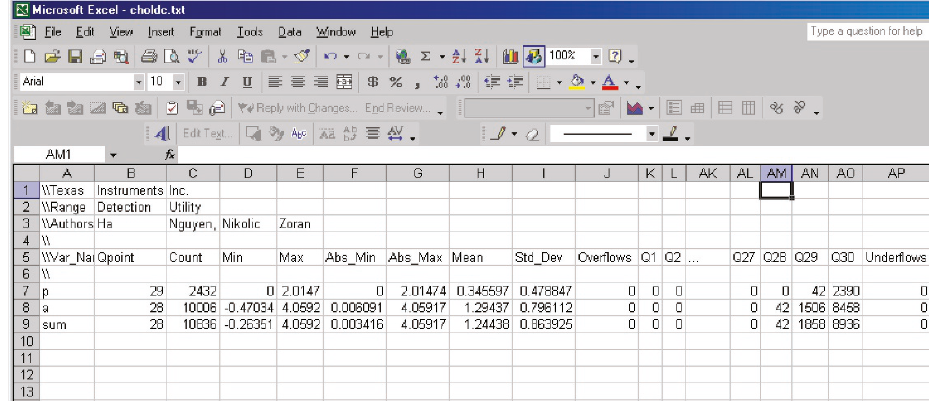
Figure 8: Output from range estimation tool imported in excel